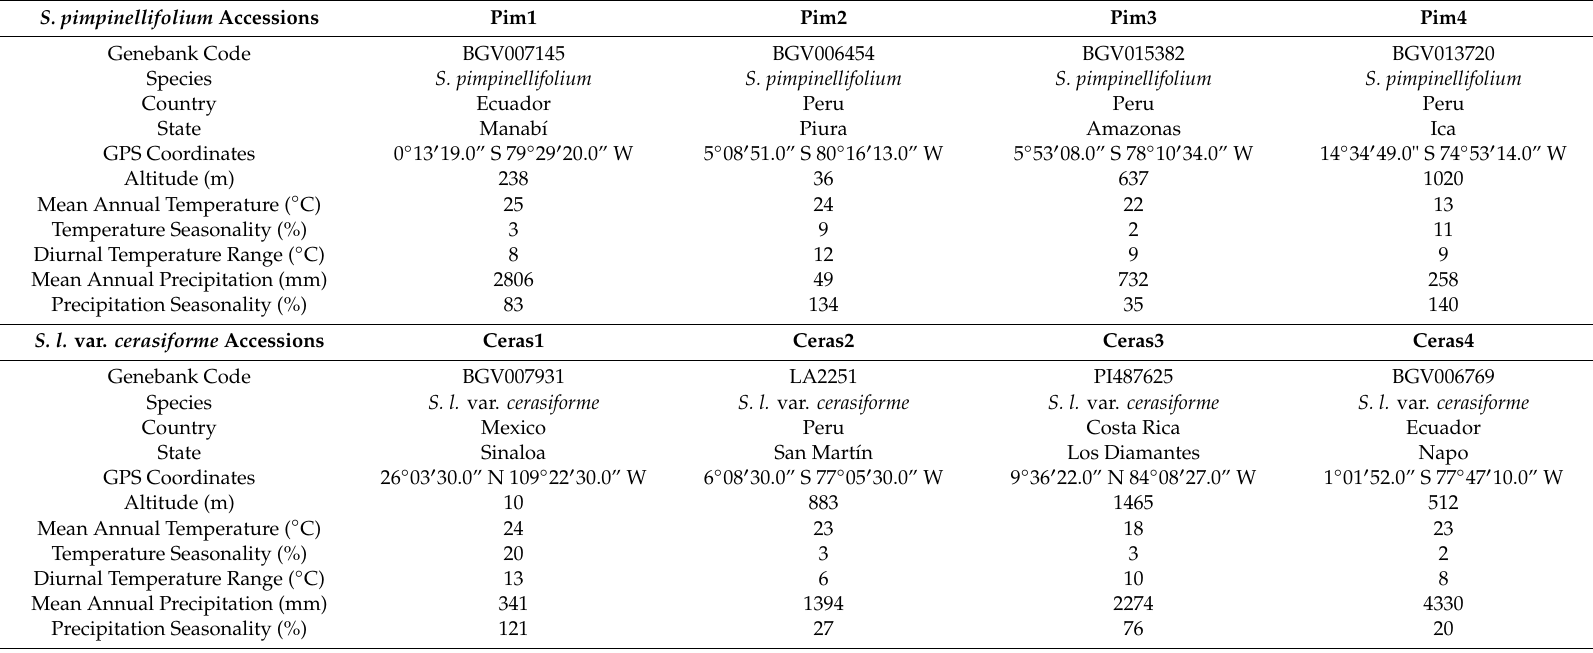
Table 1. Passport, abbreviation, and environmental data * of the eight tomato accessions used in the